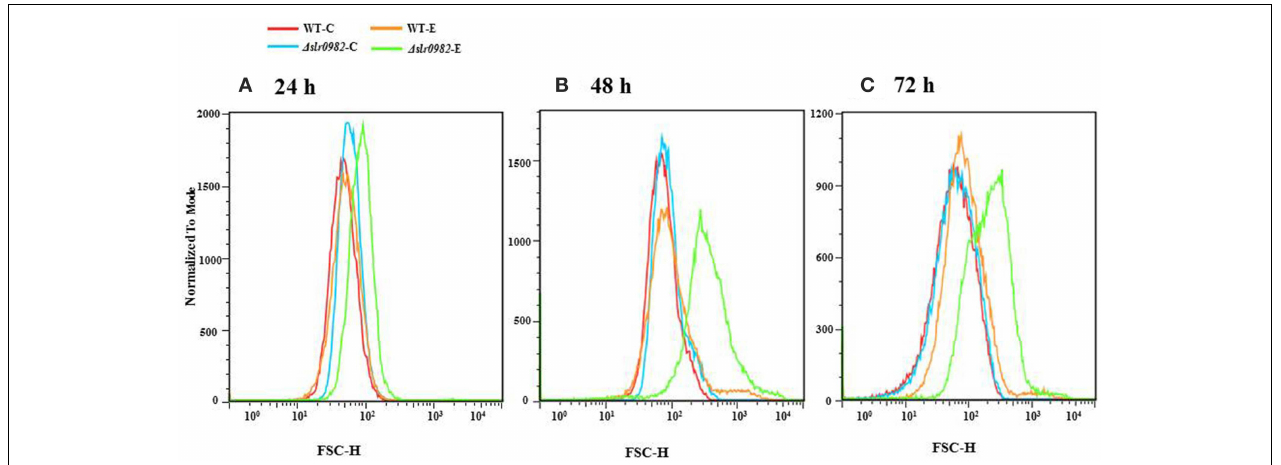
FIGURE 2 | Flow cytometric analysis of the wild type and the 1 slr0982 mutant grown in the BG11 media with or without 1.5% ( v/v ) ethanol stress. (A) 24h; (B) 48h; (C) 72h. A total of 5 × 10 4 cells were used for each analysis. Foward scatter (FSC) is related to cell